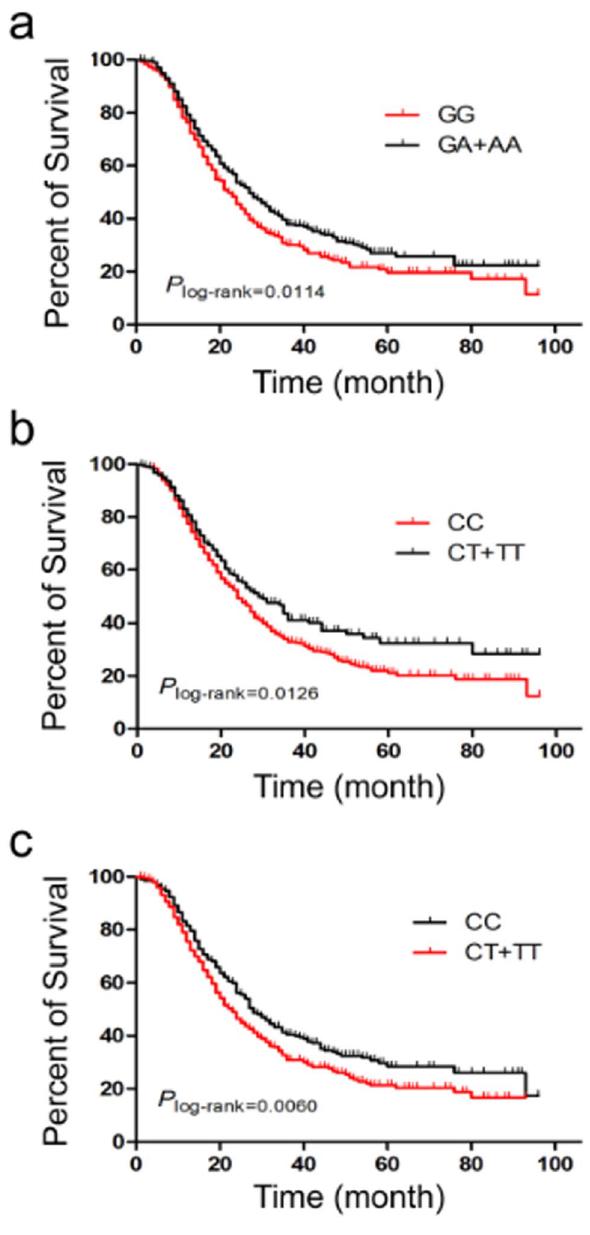
Figure 1. Kaplan–Meier estimates of overall survival of patients with small-cell lung cancer according to rs4809957G . A (a), rs36600C . T (b) or rs401681C . T (c)